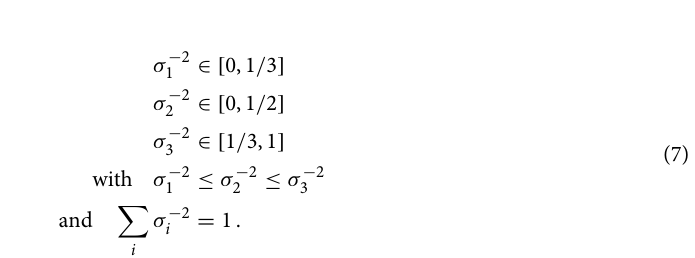
Figure 5. Coverage of the parameter space (on a 20 according to Eq. (7). The salient triangular region extending from the top right corner to the bottom (cf. center and right panels) corresponds to redundancies in the coverage of the range σ − the generation scheme, which shall here be noted for